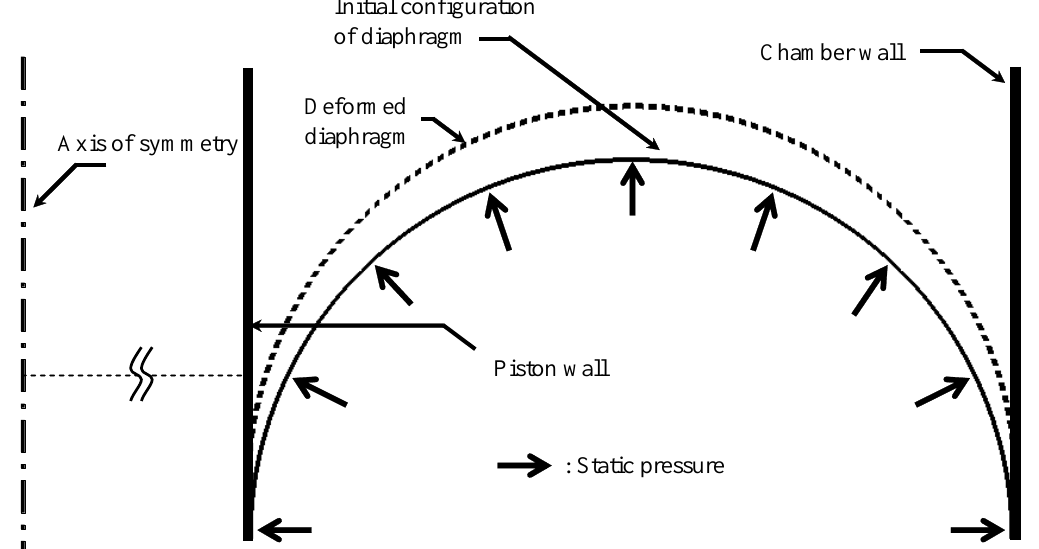
Figure 4. Finite element model of the diaphragm.